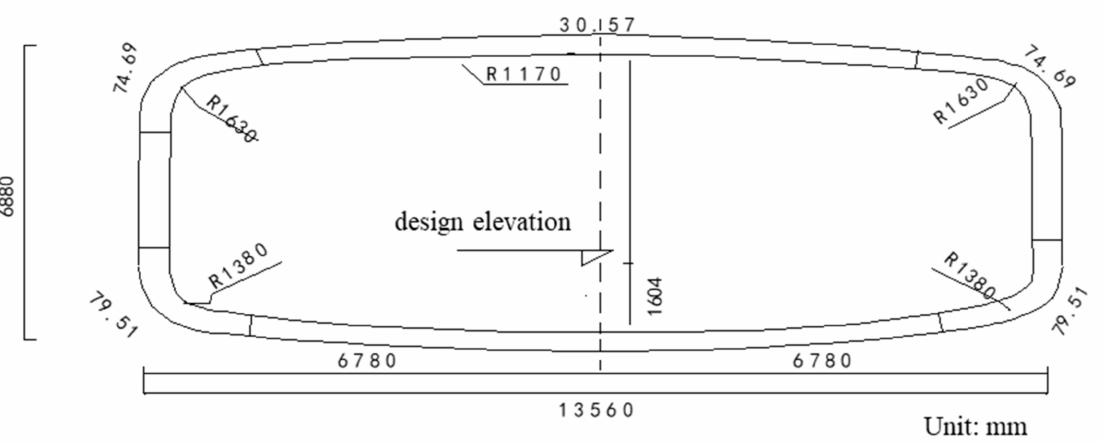
Figure 4. Schematic diagram of the cross-sectional shape of the tunnel in the surrounding rock section of grades III, IV, and